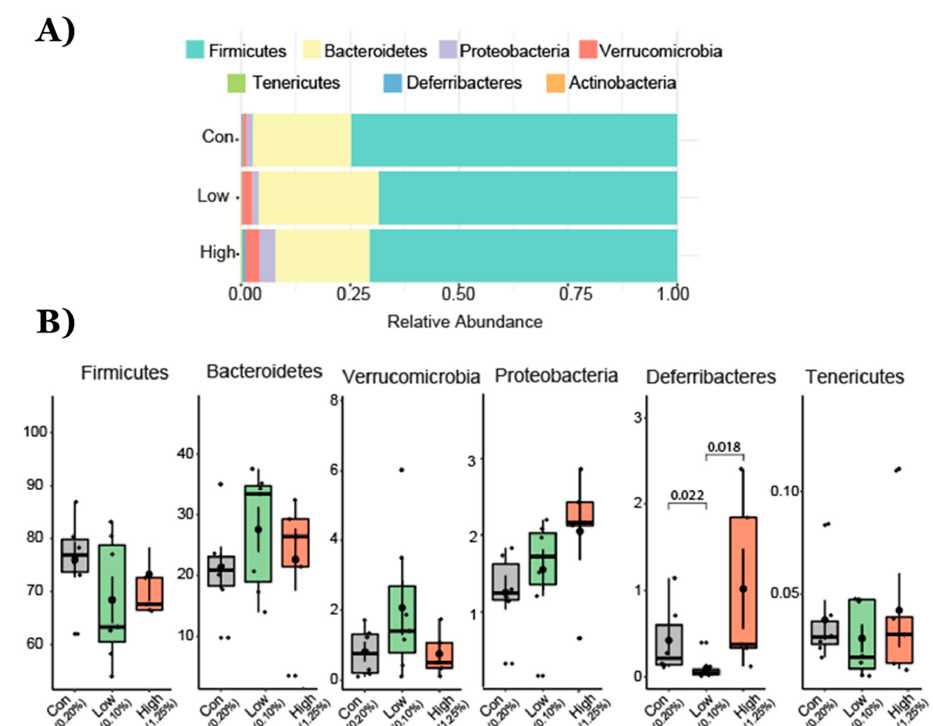
Figure 4. Operational taxonomical unit (OTU) abundance at the phylum level in animals fed with TRP-normal, TRP-deficient, and TRP-rich diets. ( A ) Relative increase in Verrucomicrobia and Bacteroideate and decrease in Firmicutes and Deferribacteres. ( B ) Box and whisker plots depict the operational taxonomical units (OTUs) from different bacterial phyla presented among three groups of mice. p values are shown where the differences were found to be significantly different from each other. Cont (control 0.2% TRP, n = 7), def/low (0.1% TRP, n = 7), and high/rich (control 1.25% TRP, n = 7).